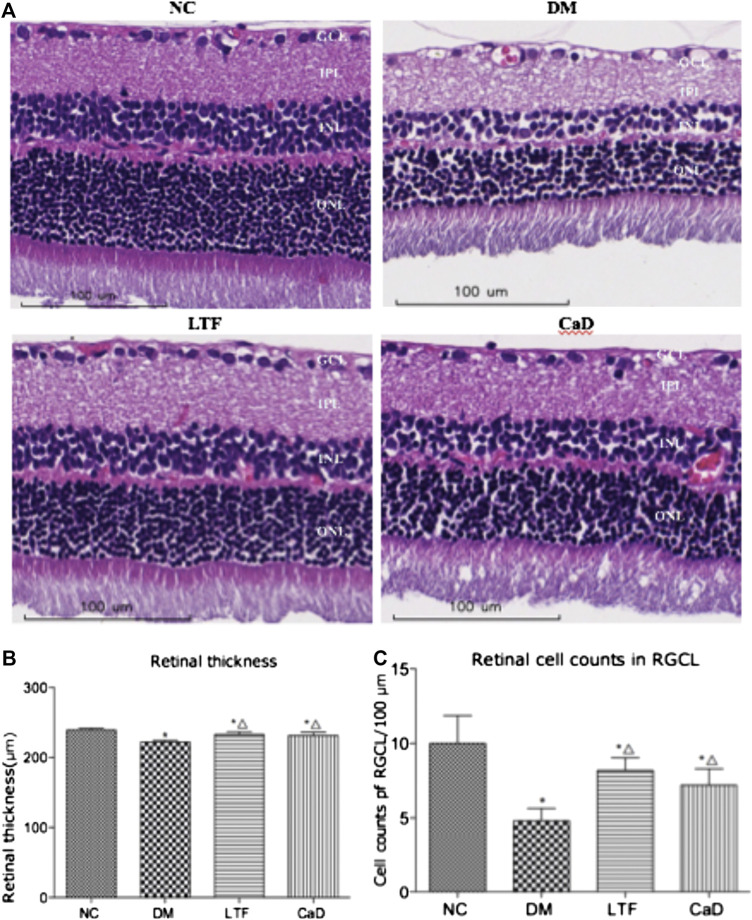
Effect of LTF and CaD on the retinal morphological changes. (A) HE staining of retina at 12 weeks (×400 magnification); (B) Toral retinal thickness; (C) Cell counts in the GCL; (B–C) Data are mean ± SD from six retinas per group. (*p < 0.05: vs. NC group; △ p < 0.05: vs. DM group).